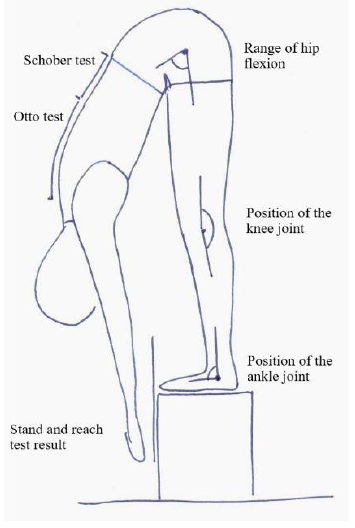
Figure 1. Measurement scheme.